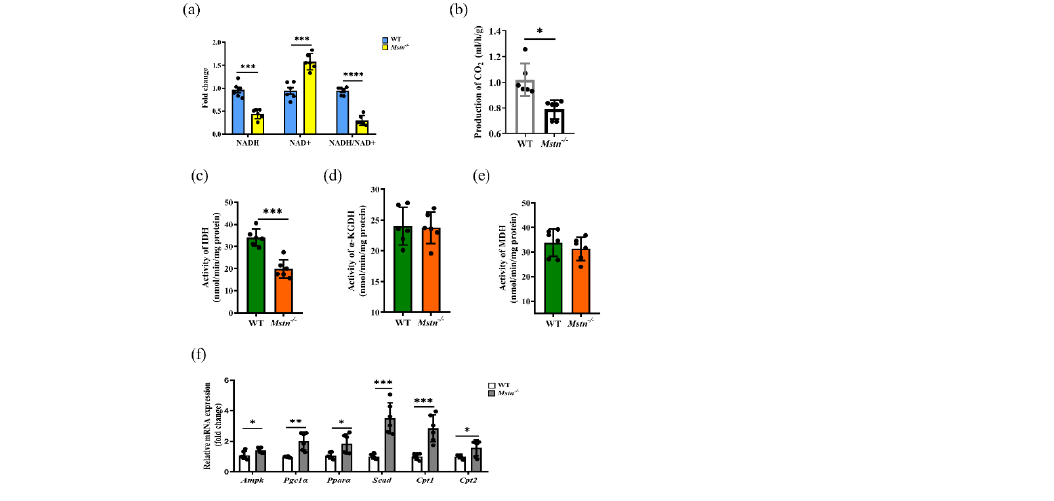
Figure 4. Mstn gene knockout-inhibited OXPHOS via the TCA cycle. ( a ) Concentrations of NADH and NAD+ in quadriceps of WT and Mstn −/− mice. ( b ) The production of CO 2 in WT and Mstn −/− mice breath. ( c ) IDH activities in quadriceps of WT and Mstn −/− mice. ( d ) α -KGDH activities in quadriceps of WT and Mstn −/− mice. ( e ) MDH activities in quadriceps of WT and Mstn −/− mice. ( f ) Expression of mRNA for the gene involved in β -oxidation in quadriceps. All the data are presented as mean ± SD. Compared with the control group, * p < 0.05, ** p < 0.01, *** p < 0.001, **** p < 0.0001; Student ’ s t-tests were used to calculate the p -values. We used n = 6 mice per group. Each dot presents a mouse.